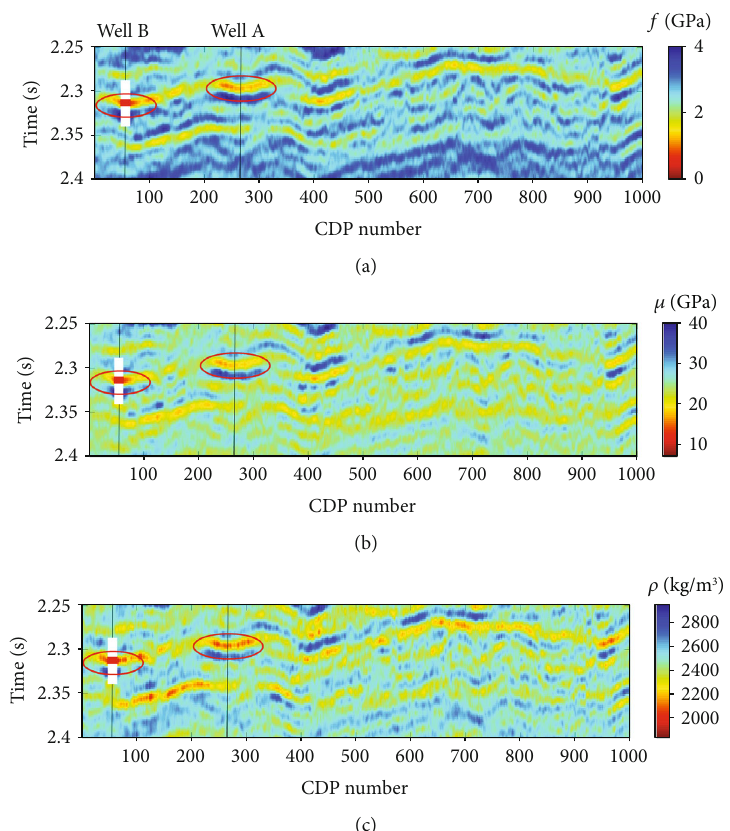
Figure 10: Estimated background elastic properties, where (a) is the fl uid/porosity term, (b) is the shear modulus, and (c) is the density.